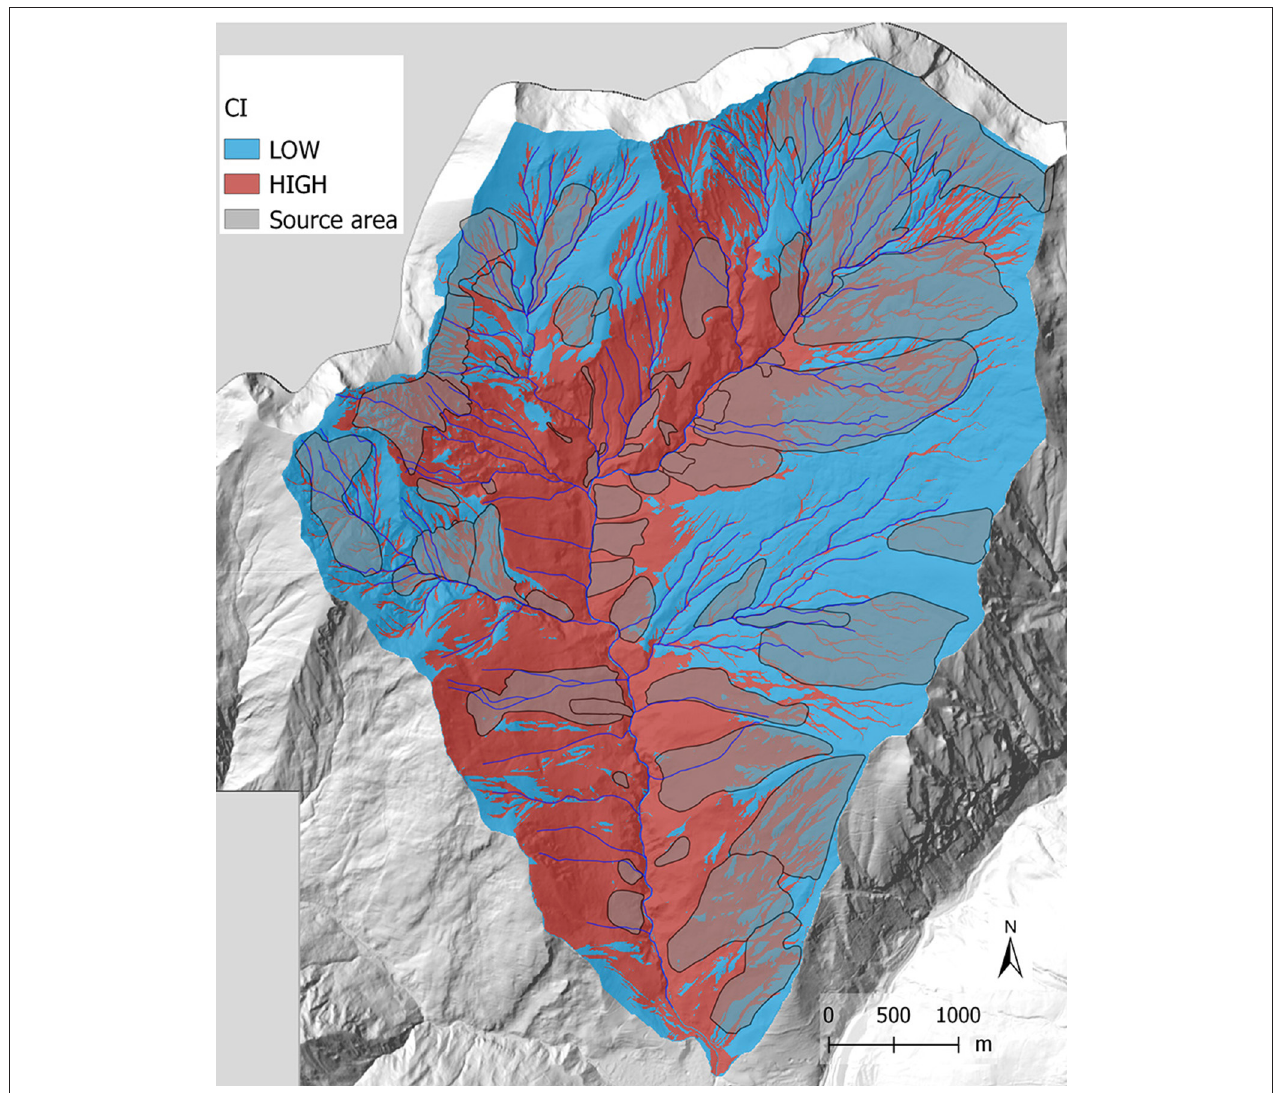
FIGURE 8 | Intersection between sediment source areas and IC